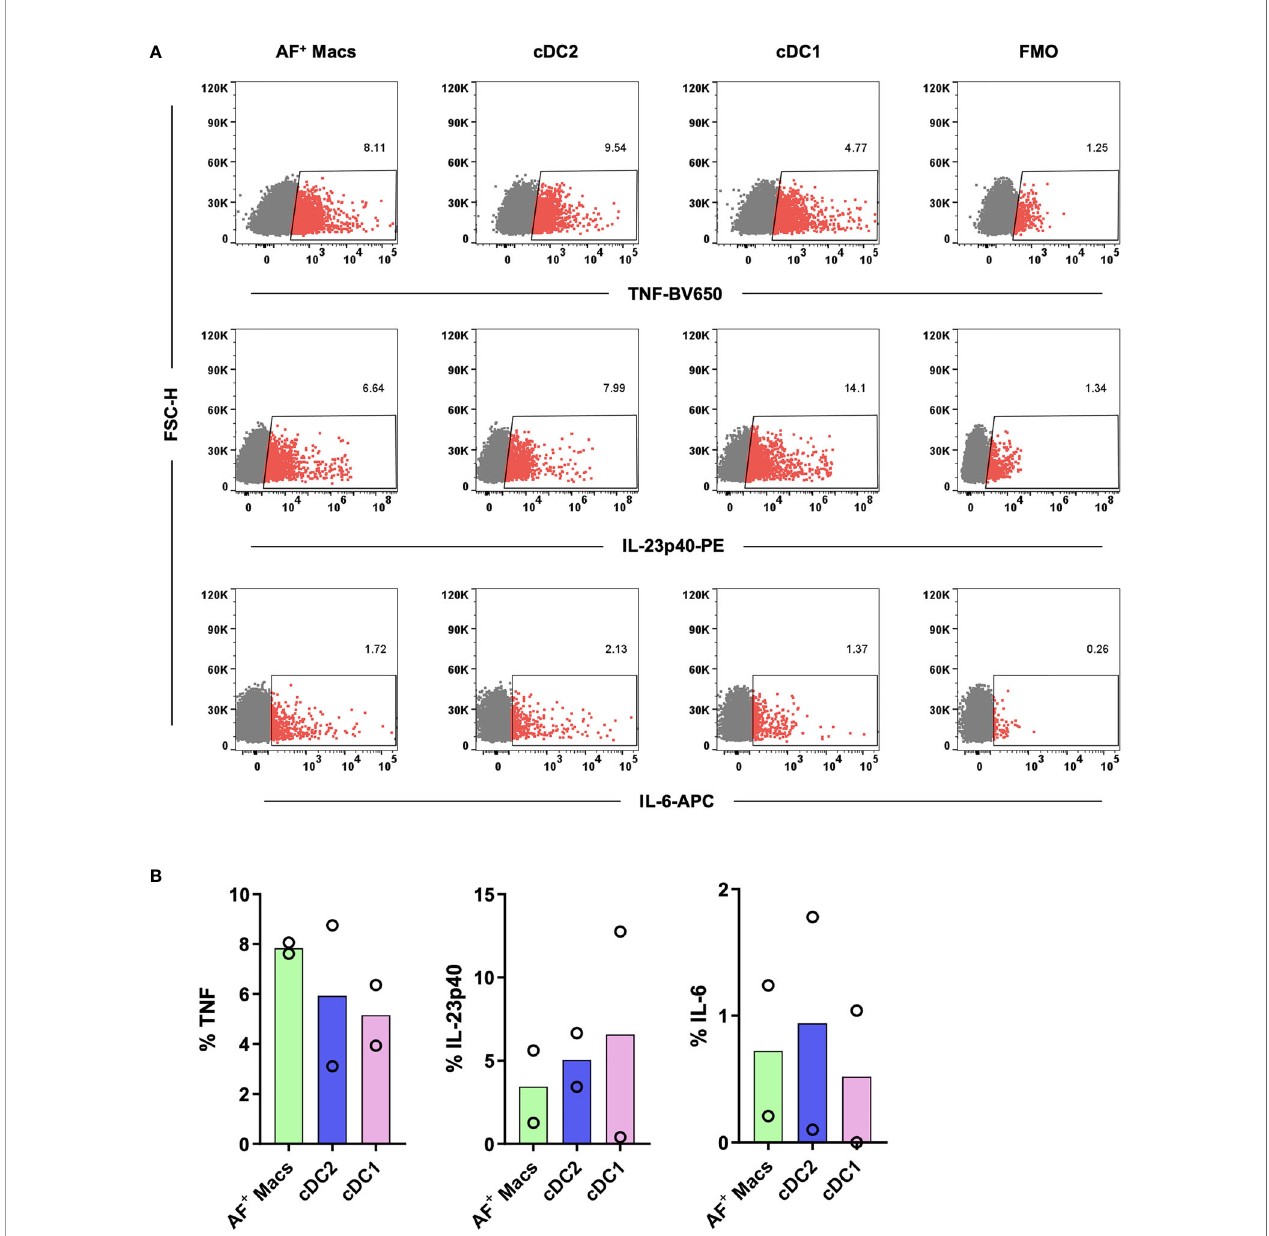
FIGURE 6 | Investigation of the cytokine responses of tissue MNPs liberated by enzymatic digestion. Intestinal mononuclear phagocytes were isolated as per Figure 1 . Cells were positively selected for CD45 and stained with FACS Sort Panel ( Table 2 ). Auto fl uorescent (AF) macrophages (Macs), conventional DC (cDC) 1 and cDC2s were sorted based on gating in Figure 4C . Sorted cells were cultured at 1x10 6 cells/mL in DC Culture Media with 1 µ g/mL R848 for 2 hours. 2.5 µ g/mL Brefeldin A was added, and the cells cultured for a further 14 hours. Cells were then stained with Fixable Viability Stain 700 and intracellularly stained with anti-TNF, anti-IL-23p40 and anti-IL-6. Cells were acquired on a FACSymphony. (A) Representative plots for expression of TNF, IL-23p40 and IL-6 on all subsets compared to Fluorescence Minus One (FMO). (B) Expression of TNF, IL-23p40 and IL-6 as a percentage of live single cells minus FMO, columns represent mean expression